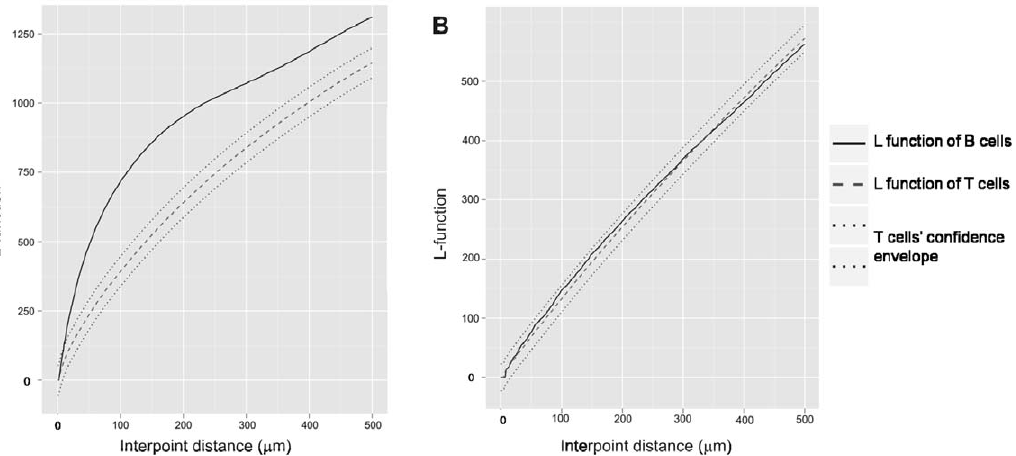
Figure 2. Representative L function plots of T and B cells in TDLNs and HLNs. (A) In most TDLNs, B cells are more clustered than the T cells, as indicated by upward deflection of the L function of B cells above the confidence envelope. (B) In the majority of the HLNs, T and B cells have a similar tendency to group or disperse at various interpoint distances, as indicated by the L function of B cells that remains within the confidence envelope.